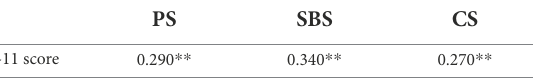
TABLE 6 Pearson correlation between PETJSS scores and TSES-11 score.